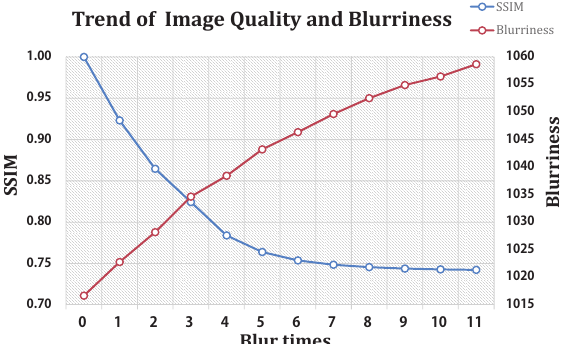
Figure 5. Trend of image quality and blurriness with Gaussian blur times that varies from 0 to 11.